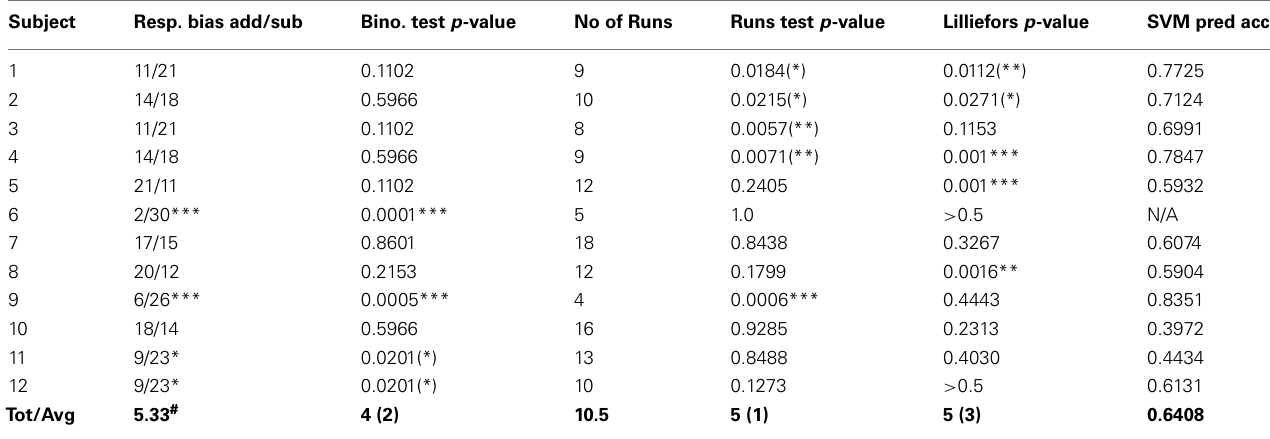
TableA2 | Replication study 2: addition/subtraction in hidden intention